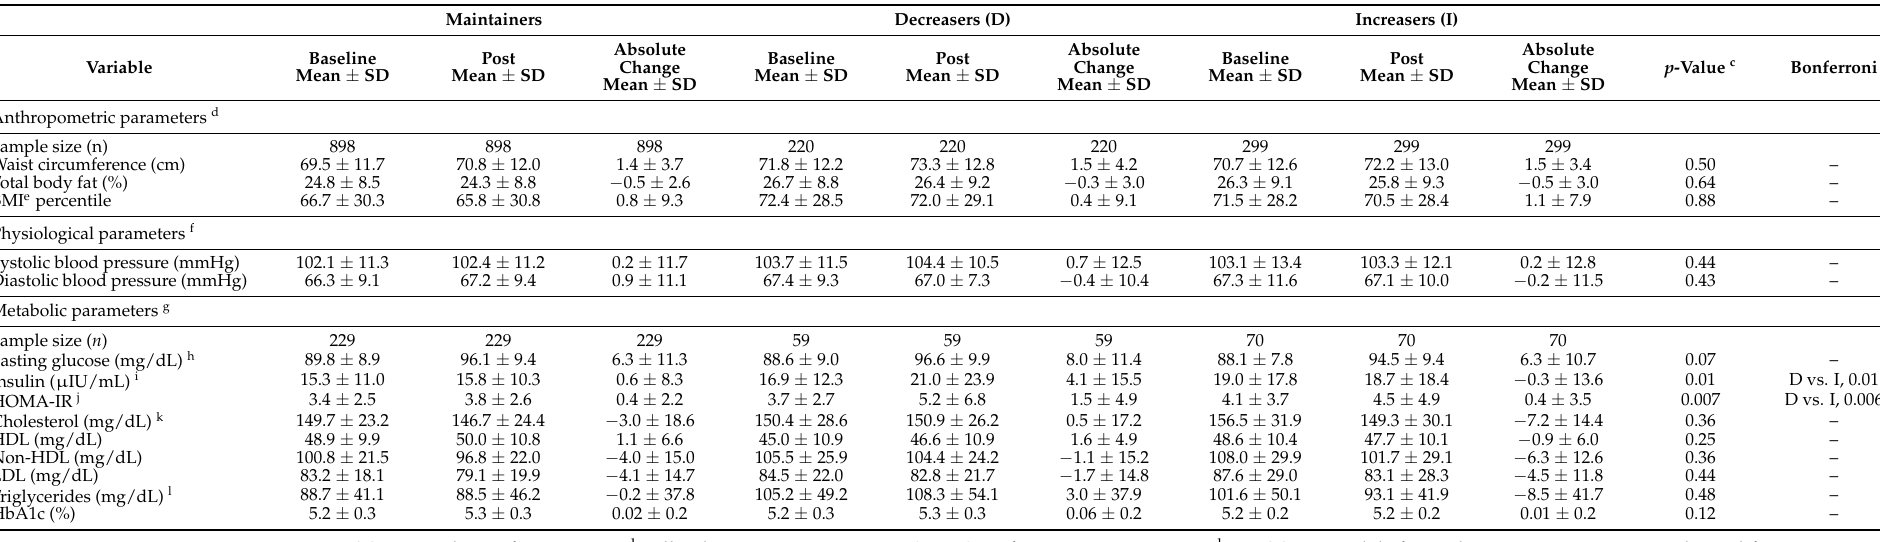
Table 3. ANCOVA a models examining anthropometric and metabolic parameters of participants by breakfast consumption b .